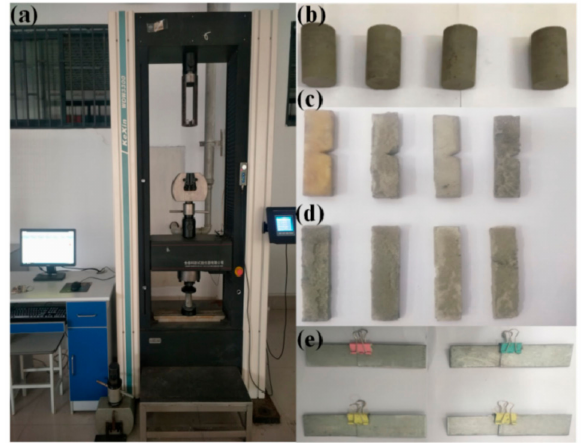
Figure2. ElectronicUniversalTestingMachine( a )andMeasuringSpecimens: ( b )CylindricalSpecimens, ( c ) Three-point Bending / DMA Specimens, ( d ) Rectangular Specimens, and ( e ) Bond Specimens of Iron